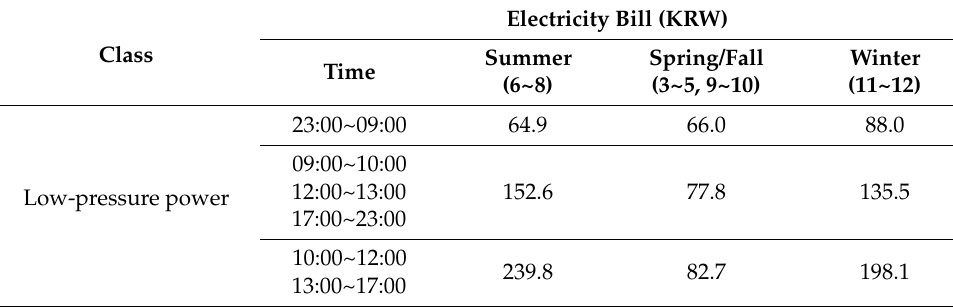
Table 8. Situational Electric Vehicle Charging Power Bill (Won/Kw) [35].